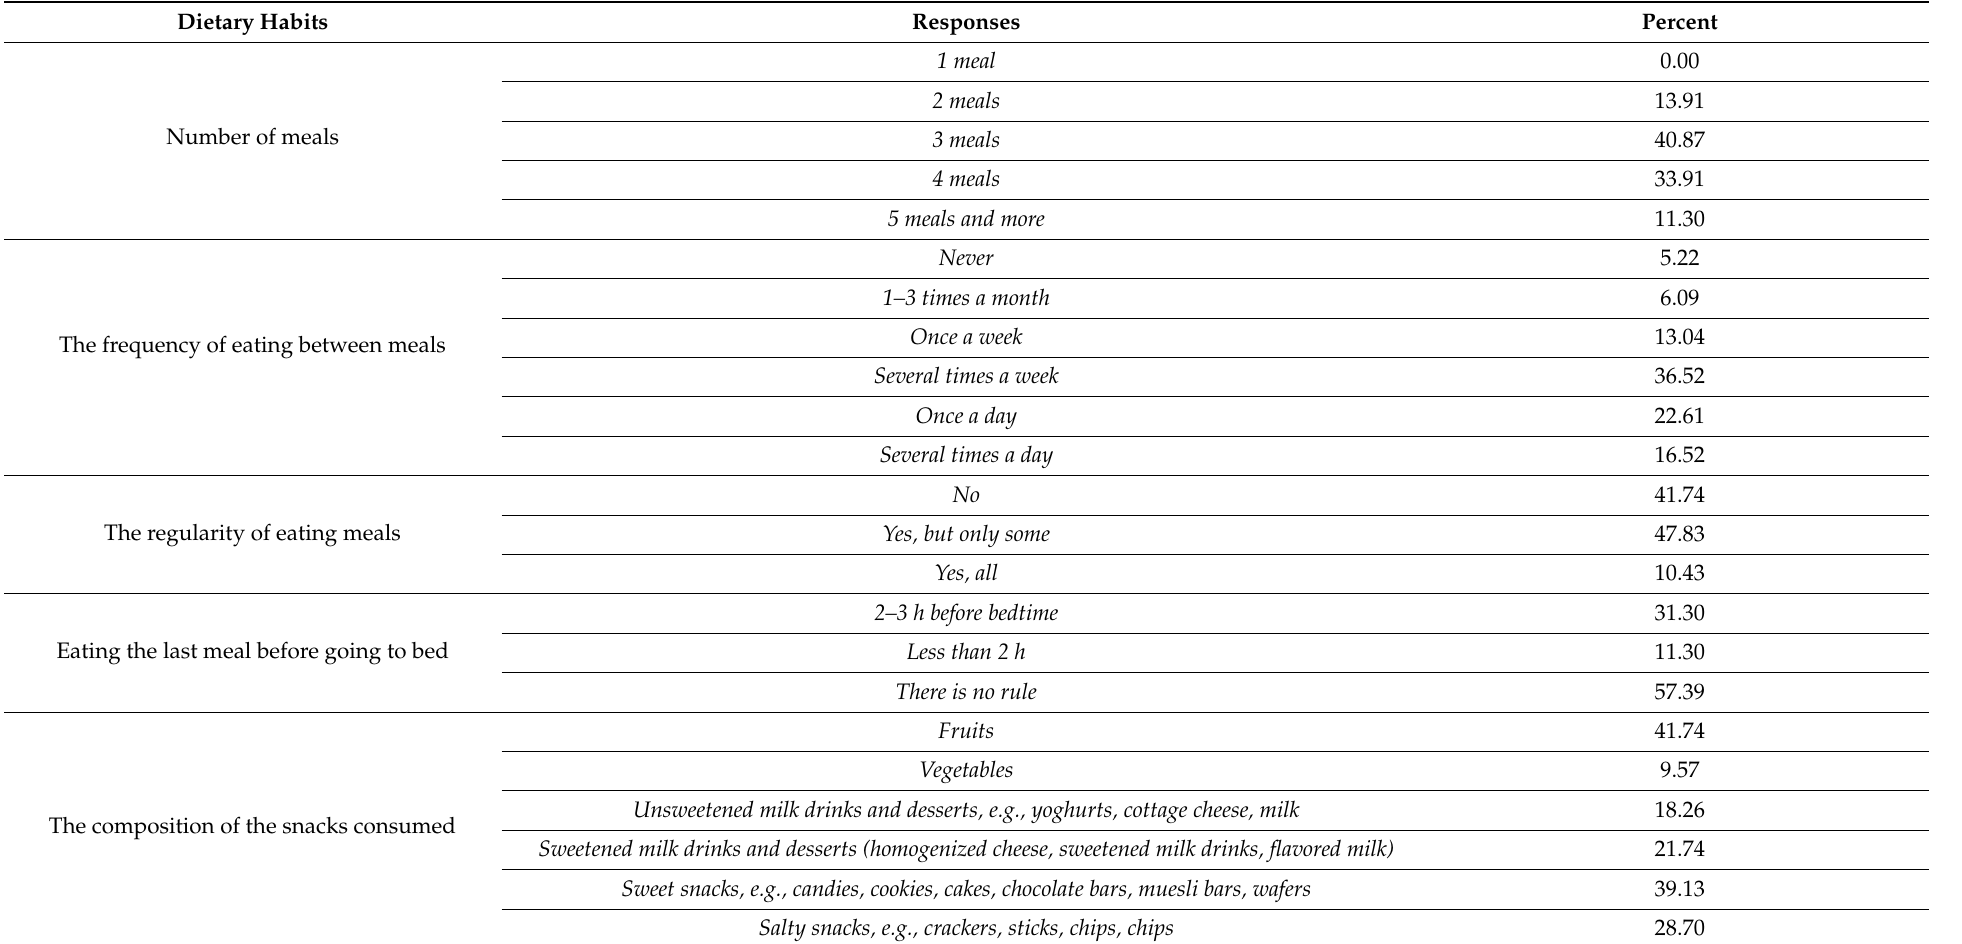
Table A1. Esports players dietary habits—percentage response